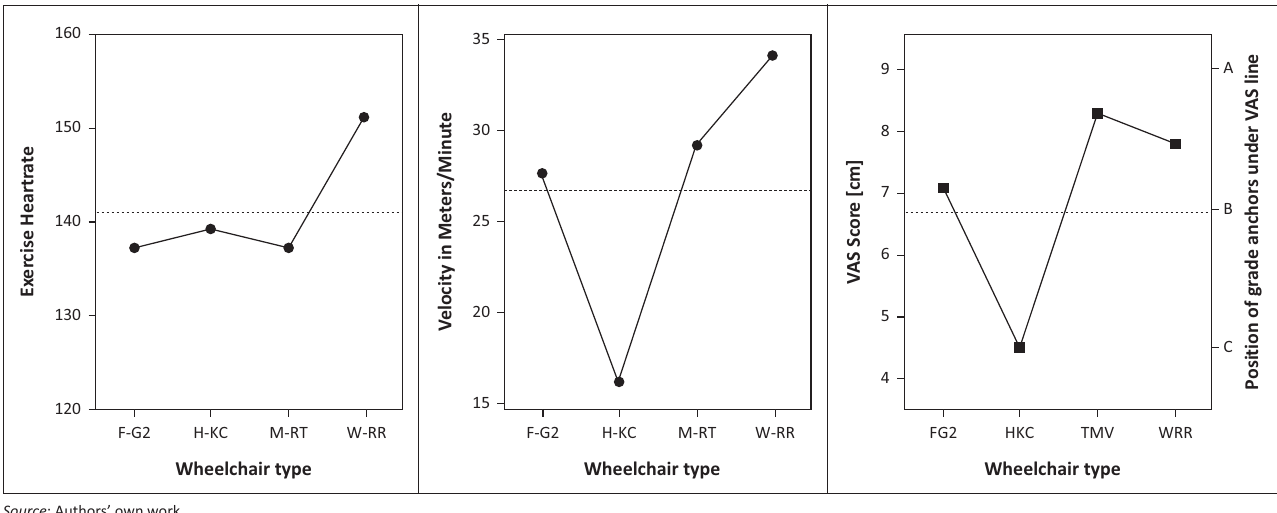
Source : Authors’ own work Plots are shown for mean exercise heart rate, velocity and participant response VAS scores. On the secondary Y-axis for VAS scores, the position of the of grade anchors under the VAS line is indicated to show perceived ratings. FIGURE 4: The analysis of variance main effects plots the comparison between Free Wheelchair Mission Generation 2, Hope Haven KidChair, Whirlwind Roughrider and MRT wheelchairs for the 12 participants able to complete the curb track in all four wheelchair TABLE 3: Coded and counted comments from all runs in any wheelchair on the curb rolling environment. HKC FG2 WRR MRT Number and topic of negative comments appearing more than twice